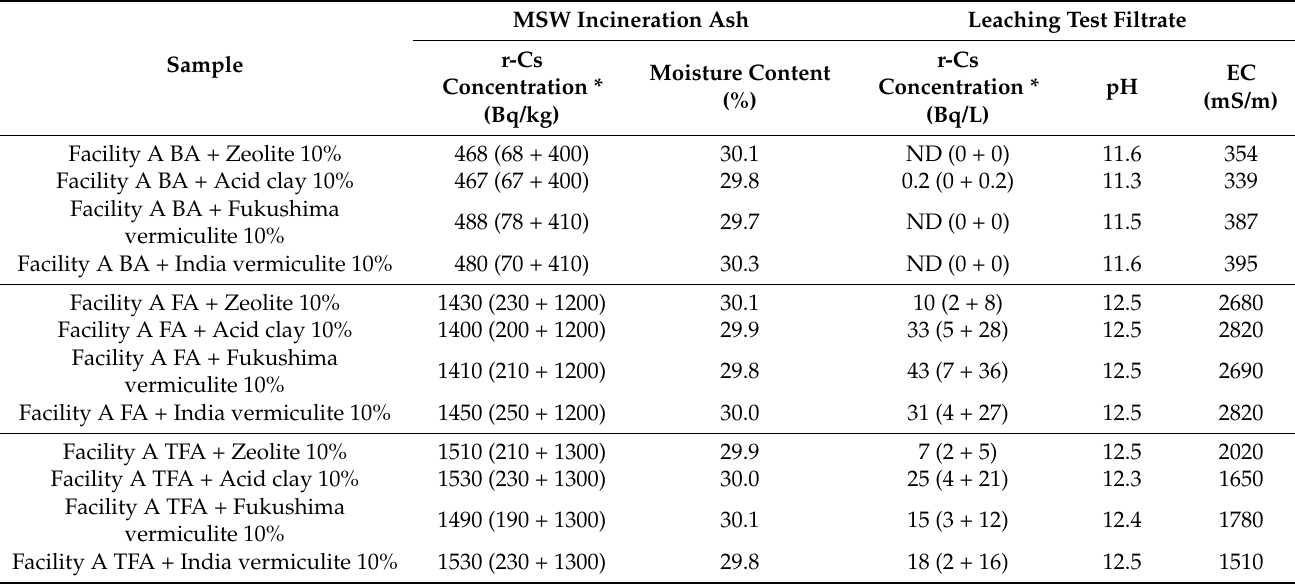
Table 4. Concentration and leaching of radioactive cesium (r-Cs) upon direct addition and mixing of clay minerals at 10 wt.%.